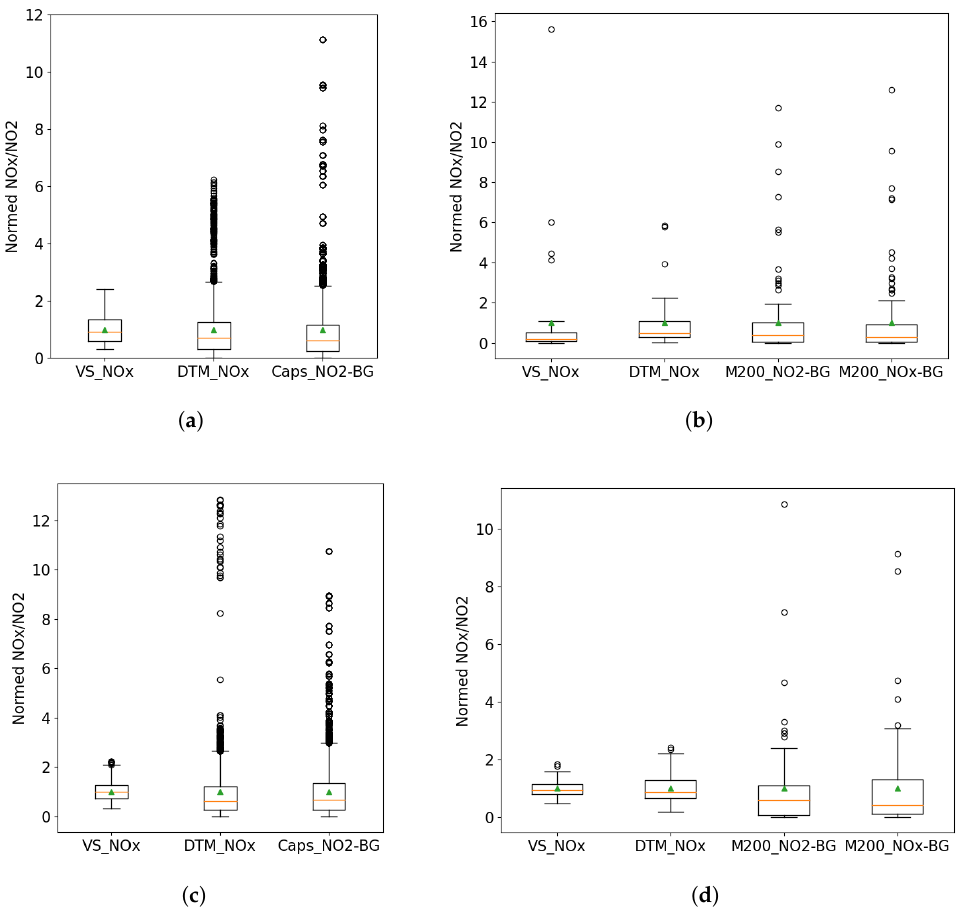
Figure 10. Comparison of measured and modelled box plots. ( a ) Day 1 CAPS (30 s rolling average), ( b ) Day 1 M200e (60 s average), ( c ) Day 2 CAPS (30 s rolling average), ( d ) Day 2 M200e (60 s average). The green triangle indicates the mean, the orange line the median and the whiskers extend 1.5 × the inter-quartile range. An approximation of the background concentration has been subtracted from the measured NO 2